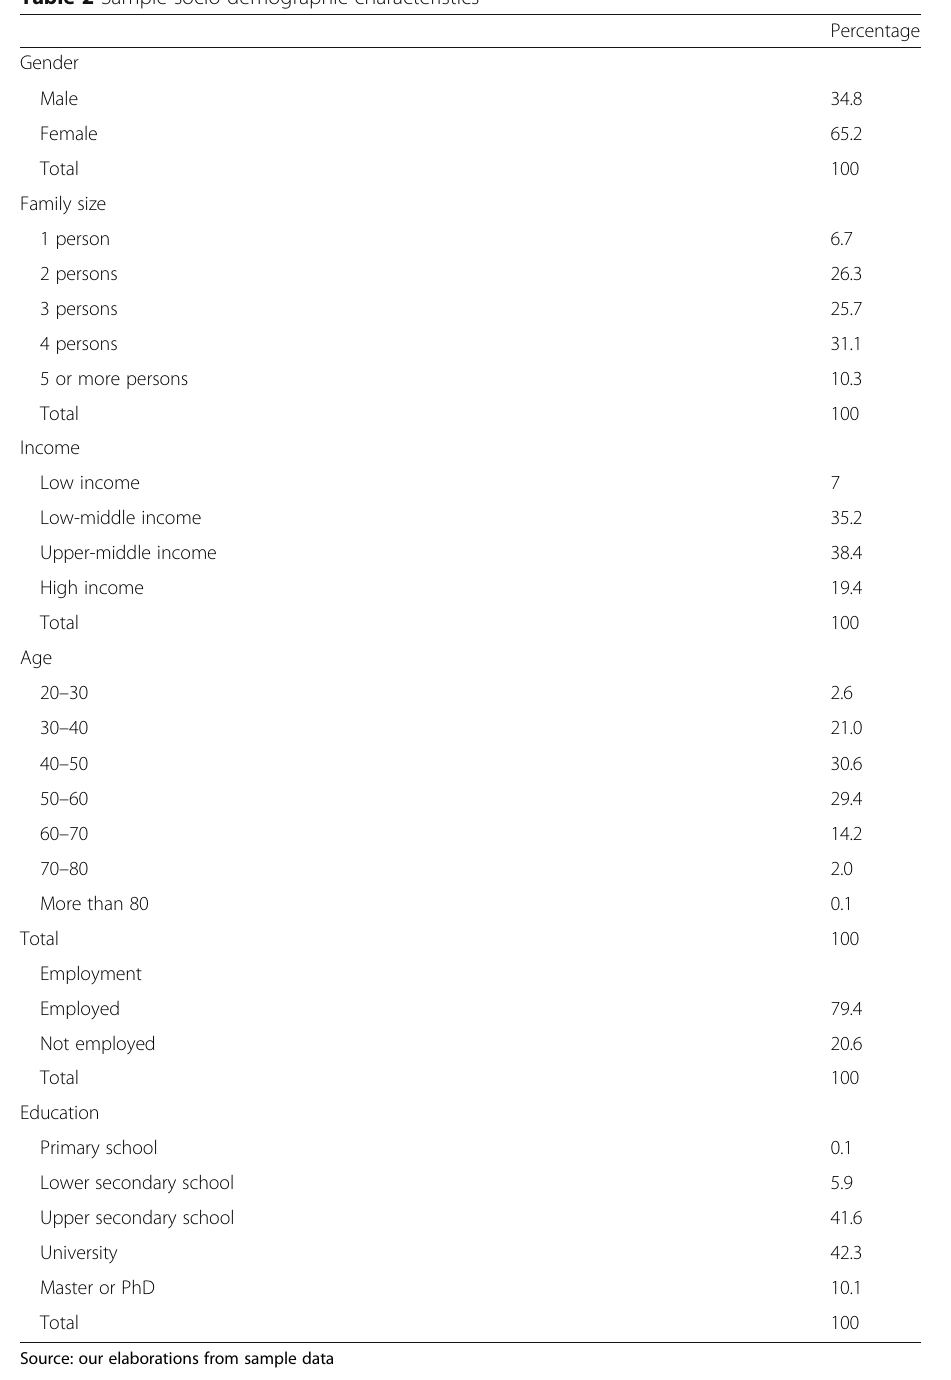
Table 2 Sample socio-demographic